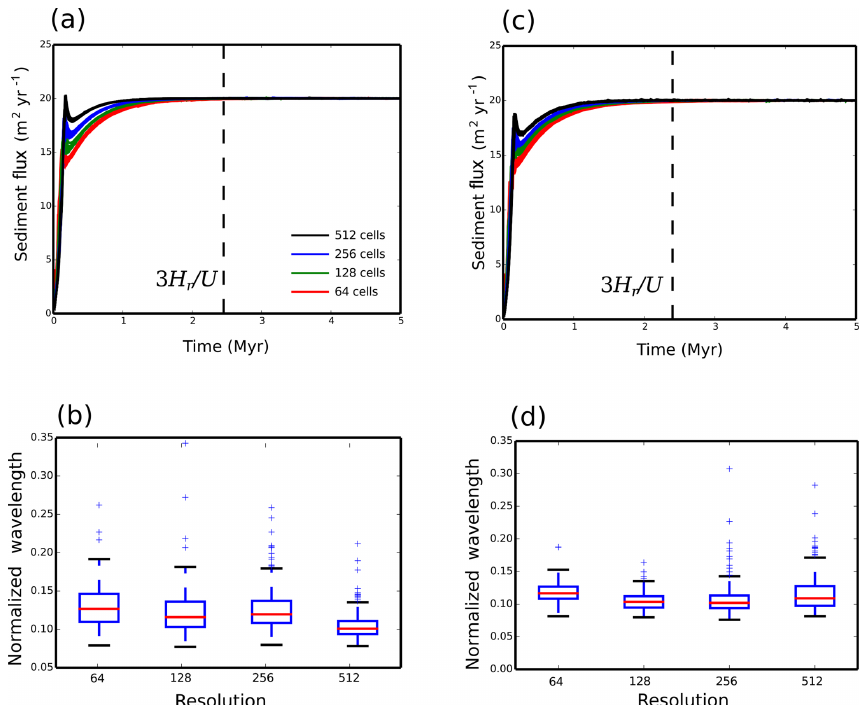
Figure 5. Dimensional sediment flux that exits the model domain and box–whisker plots of the dimensionless valley-to-valley wavelength for each model for different resolutions, where the number of cells along the y axis is shown. (a) Sediment flux and (b) valley-to-valley wavelength for the cell-to-cell SFD algorithm. (c) Sediment flux and (d) valley-to-valley wavelength for the cell-to-cell MFD algorithm. The dashed line in panels (a) , (c) , and (e) marks the time at which erosion balances uplift, given by t ≥ 3 H r /U , where H r is the relief height and U is the uplift rate (Howard,